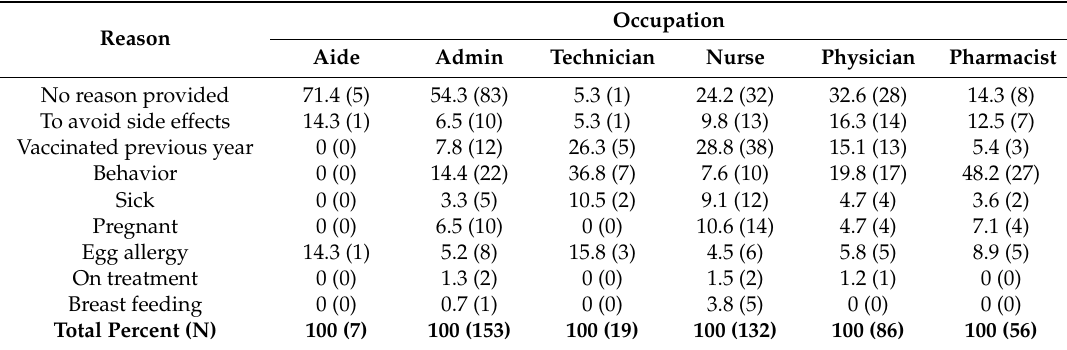
Table 3. Main reasons reported for not receiving influenza vaccinations by